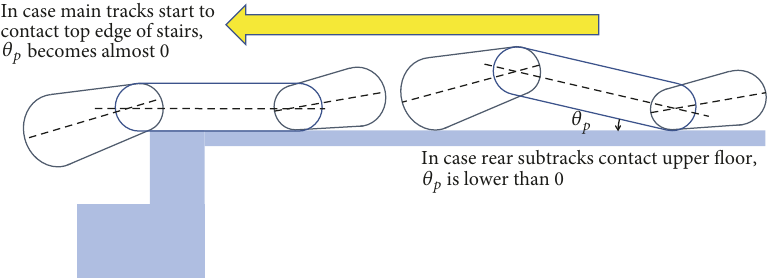
Figure 12: Position detection when the robot starts climbing